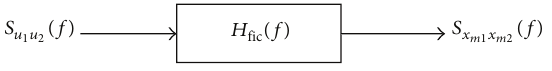
Figure 3: Fictitious linear time-invariant system.